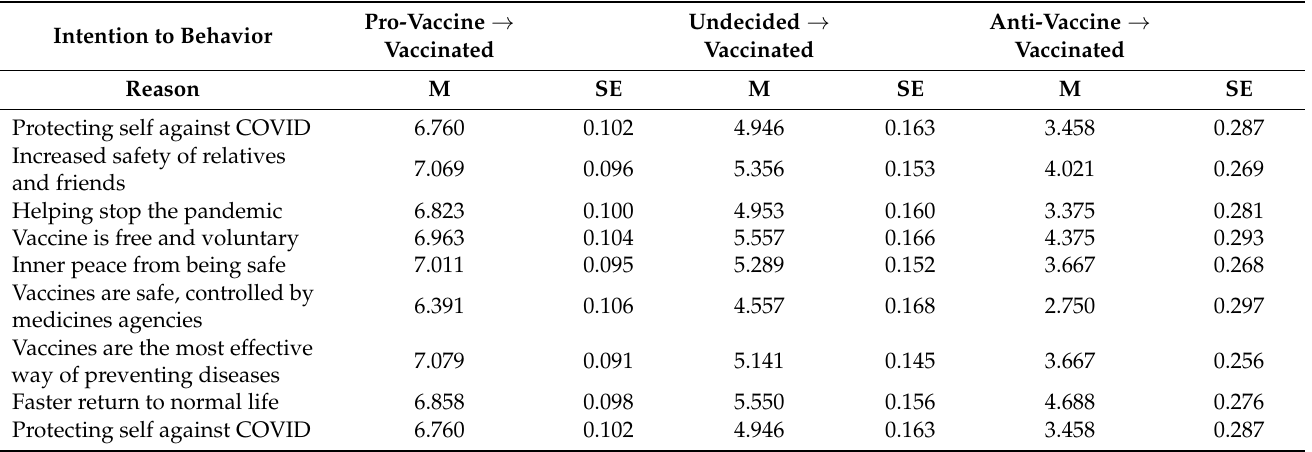
Table 4. Support for reasons to vaccinate between previously pro-vaccine, anti-vaccine and undecided groups who got